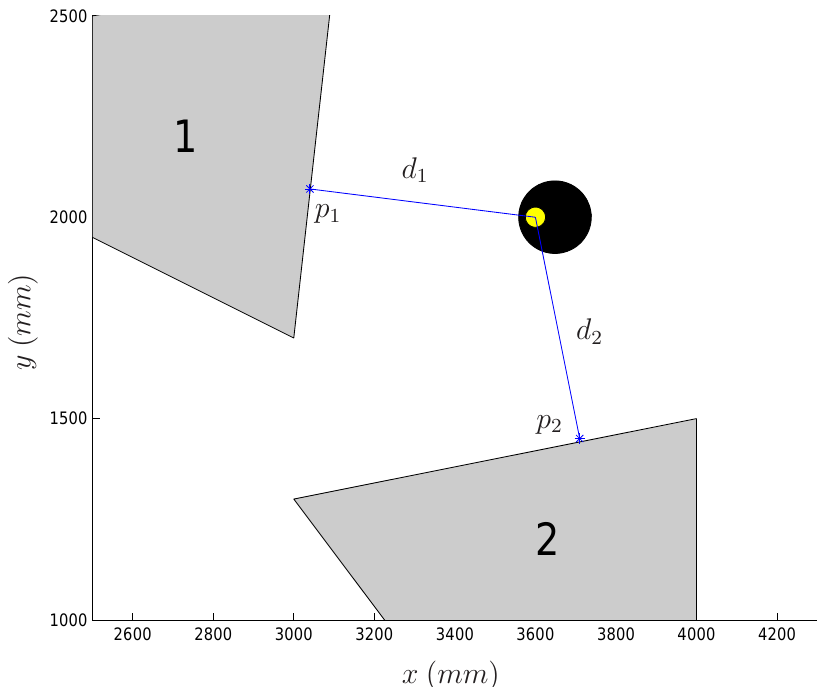
Virtual obstacles: for each robot, the minimum distance to each obstacle ( d i , i = 1 , 2) and the point of minimum distance ( p i , i = 1 , 2) are computed and stored into a suitable Matlab